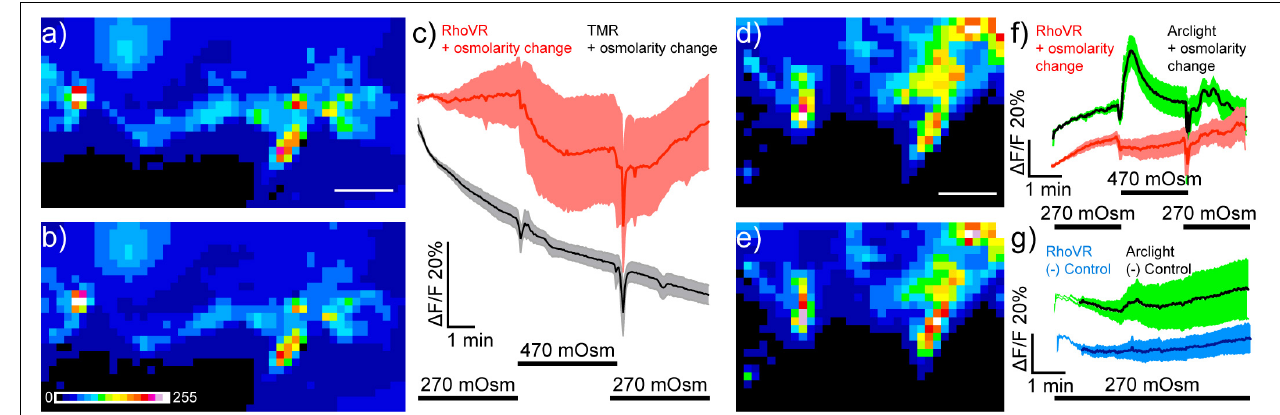
FIGURE 9 | Imaging osmolarity induced hyperpolarizations in Drosophila interoceptive neurons in live explants using single color and dual-color imaging. Spinning disk confocal maximum z-projections of live explant Drosophila brain expressing HaloTag in ISNs (Nanchung-Gal4, UAS-HaloTag/Nanchung-Gal4, UAS-HaloTag; TM2/TM6B) (a) before and (b) after stimulation with high osmolarity hemolymph (470 mOsm). Scale bar is 50 µ m. Image is pseudo-colored, and the scale bar indicates 8-bit pixel gray values. (c) Plot mean of fluorescence (% (cid:49) F/F) vs. time in response to one osmolarity simulation of either RhoVR-Halo (red, n = 5) or HT-TMR (black, n = 5) loaded brains. Data are mean ± SEM Black bars below indicate the stimulation time course switching from 270 to 470 mOsm. Maximum z-projections of live explant Drosophila brain expressing HaloTag and Arclight in the ISNs (Nanchung-Gal4, UAS-HaloTag/UAS-Arclight; TM2/TM6B) (d) before and (e) after stimulation with high osmolarity hemolymph (470 mOsm). (f) Plot mean of fluorescence (% (cid:49) F/F) vs. time for simultaneously imaged Arclight (green) and RhoVR-Halo (red) in response to high osmolarity simulation ( n = 7). (g) Plot mean of fluorescence (% (cid:49) F/F) vs. time for simultaneously imaged Arclight (green) and RhoVR-Halo (red) in response a vehicle control ( n =